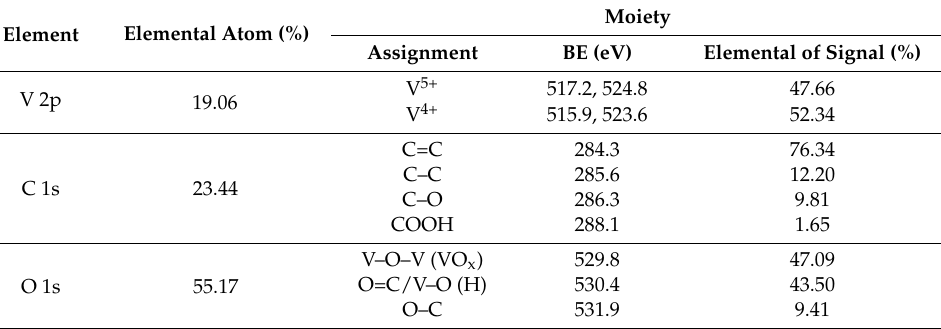
Table 1. XPS analysis of VO 2